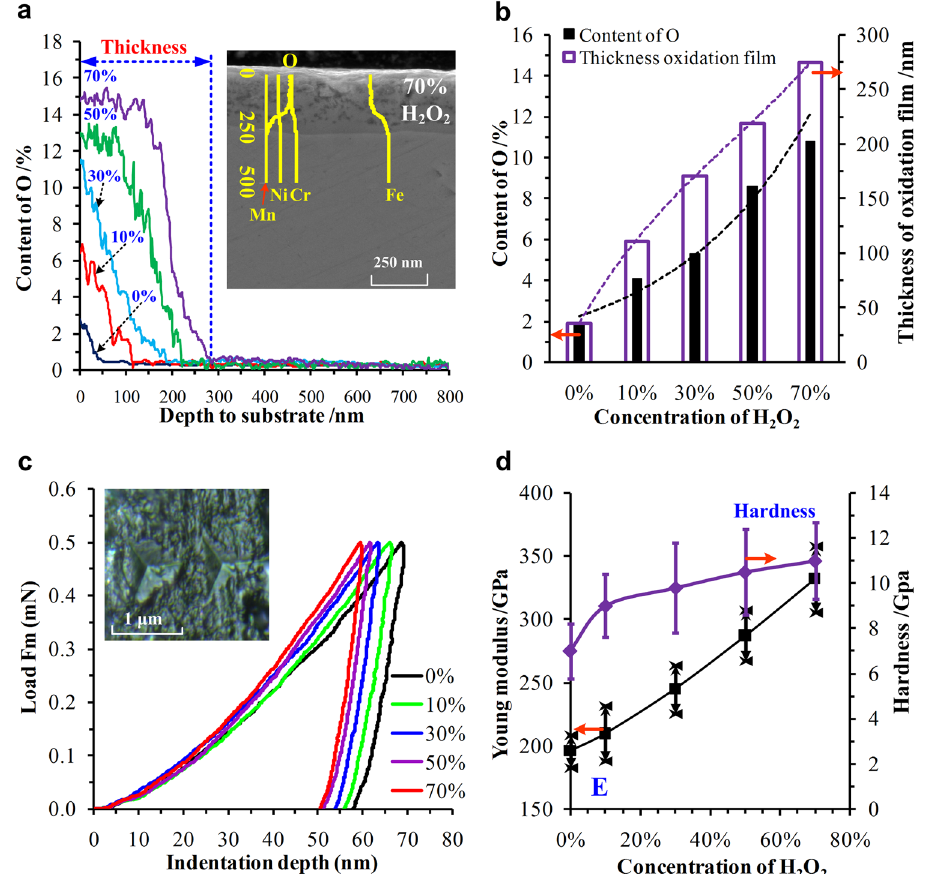
Figure 4. Characteristics of the metal oxide films covering the wear surfaces of the ring-discs. ( a , b ) Thicknesses and oxygen contents of the metal oxide films and ( c , d ) Young modulus and hardness of the metal oxide films at room temperature.